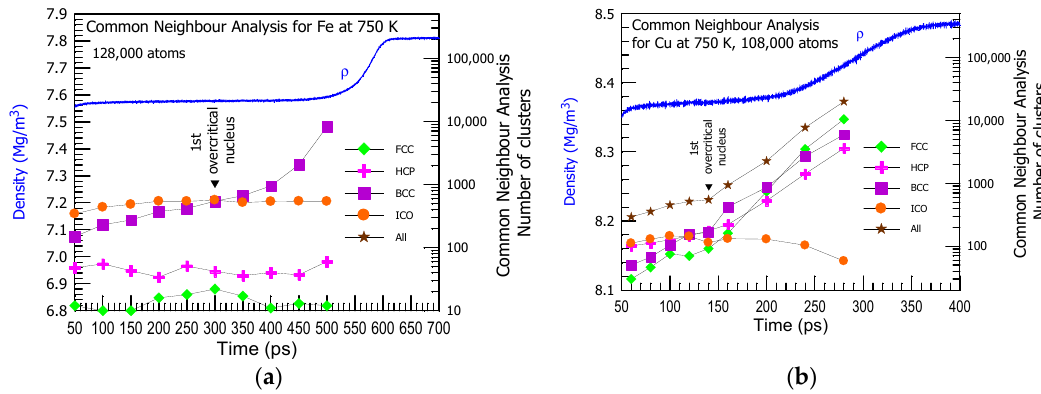
Figure 6. Adaptive common neighbor cluster analysis for Fe ( a ) and Cu ( b ) cells at 750 K together with the density ( ρ ) curve (blue) as a function of time.